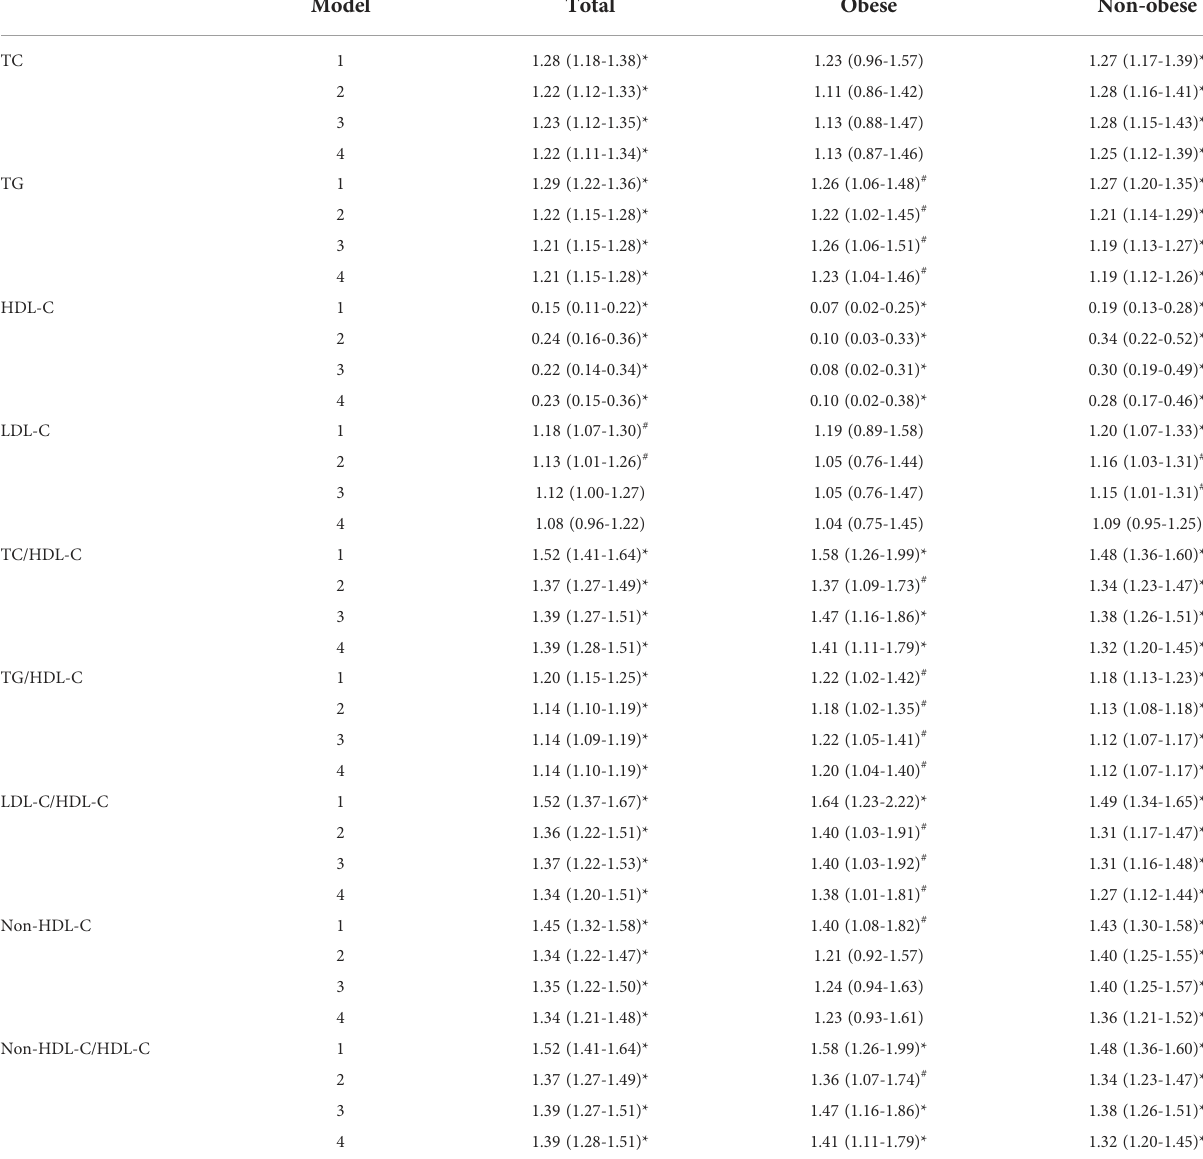
TABLE 2 Odds ratios and 95% con fi dence intervals of lipid parameters for non-alcoholic fatty liver disease according to obesity status. Model Total